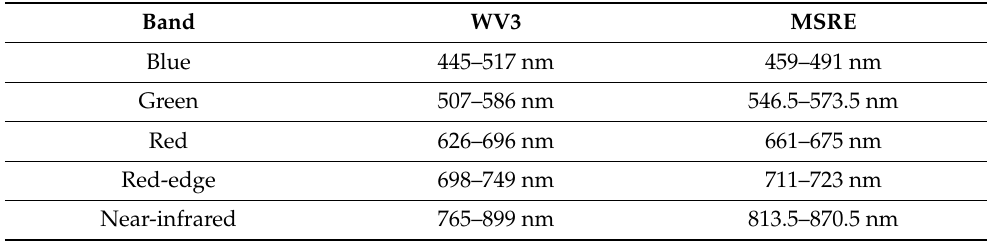
Figure 2. Relative spectral responses at each band according to Gaussian functions were used to simulate the shared bands of ( a ) WorldView-3 (WV-3) earth observation satellite and ( b ) Micasense RedEdge-MX (MSRE) uncrewed aerial vehicle sensors—from left to right: blue, green, red, red-edge, and near-infrared band locations are shown. Table 3. The effective bandwidths of the overlapping bands for both WorldView-3 (WV3) and Micasense RedEdge-MX (MSRE) sensors.